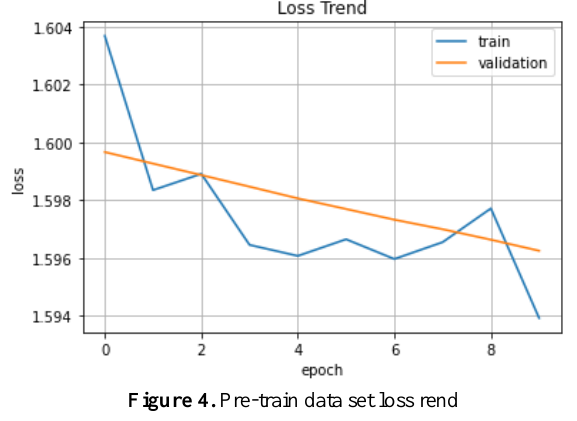
Figure 4. Pre-train data set loss rend